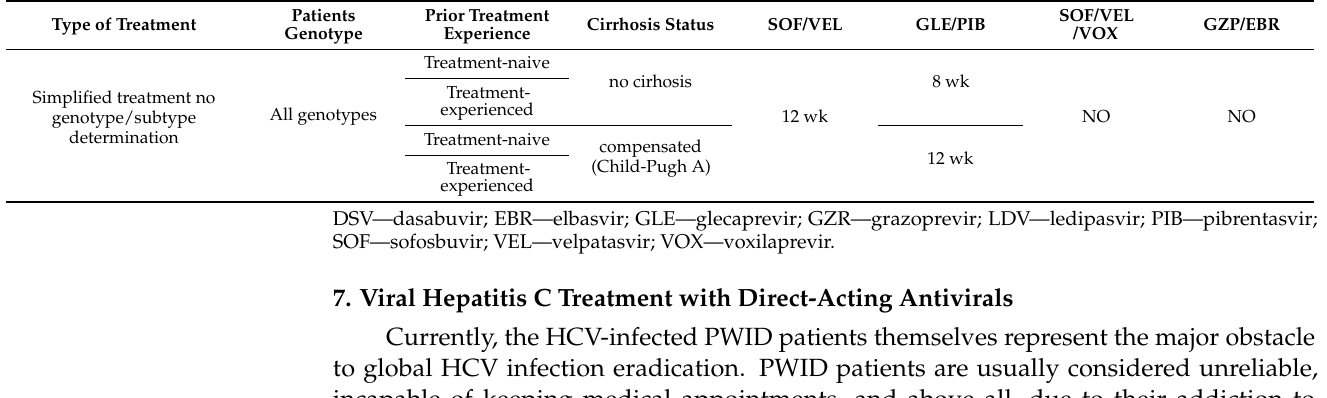
Table 2. Simplified treatment modalities for patients without or with compensated liver cirrhosis